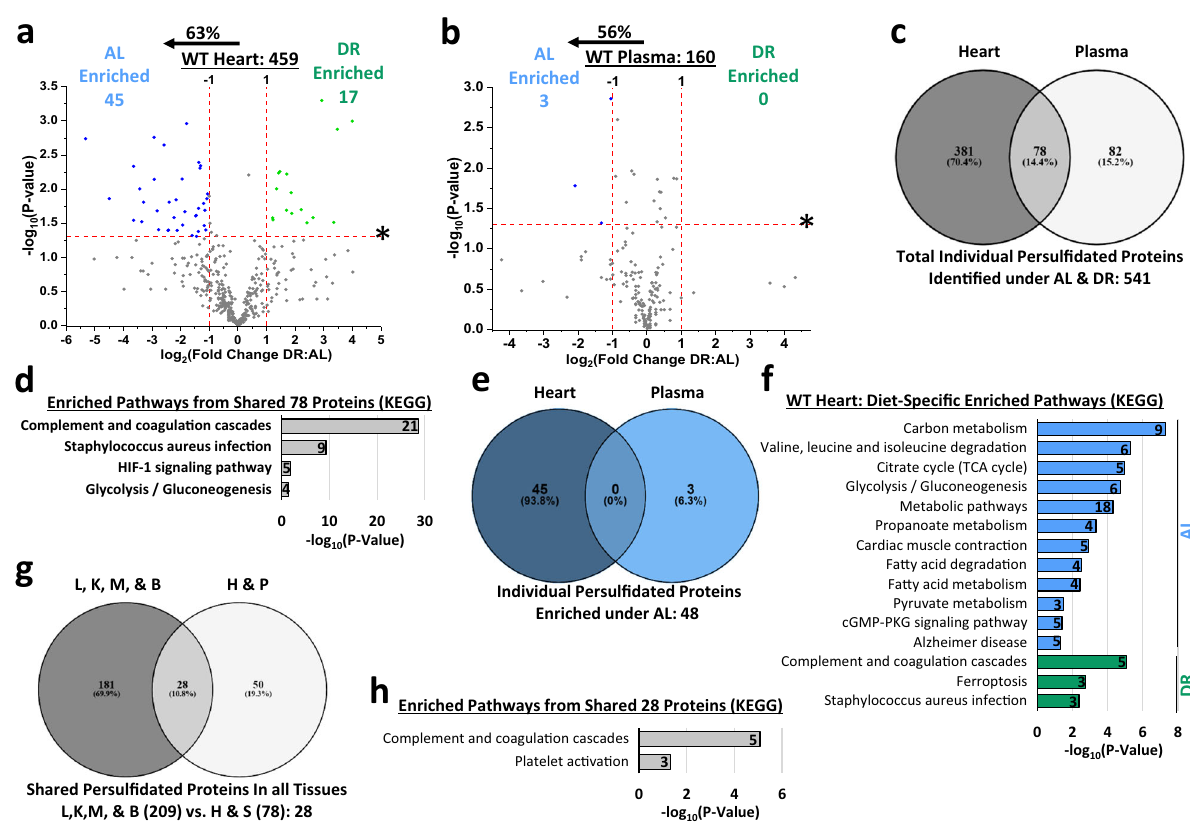
Fig. 4 Persul fi domes of heart and plasma respond differently to diet compared to those of liver, kidney, muscle, and brain. a , b Volcano plots showing differentially abundant persul fi dated proteins in heart ( a ) and plasma ( b ) from AL ( n = 4 mice/group) versus DR ( n = 5 mice/group) cystathionine γ -lyase (CGL) wildtype (WT) mice. The log 2 (Fold Change DR:AL) X-axis displays the average fold change in spectral counts for each identi fi ed persul fi dated protein while the − log 10 Y-axis displays the calculated P value when comparing the individual spectral count values for each identi fi ed persul fi dated protein in a speci fi c tissue from AL versus DR fed mice with P values obtained from two-sided Student ’ s t test. The number of total persul fi dated proteins identi fi ed in each tissue are given next to the tissue name, while blue (AL enriched) and green (DR enriched) colored dots and text indicate persul fi dated proteins reaching both biological- and statistical-thresholds. Gray color dots indicate persul fi dated proteins not reaching the criteria for both biological and statistical signi fi cance for enrichment under either diet. The percentage and direction of proteins skewed toward AL is provided above the tissue label. c Venn diagram of shared and non-shared persul fi dated proteins in heart and plasma. d KEGG biological pathway enrichment of the shared 78 proteins found in heart and plasma via g:Pro fi ler analysis. e Overlap of AL enriched persul fi dated proteins in heart and plasma. f KEGG biological function and pathway enrichment of AL enriched (blue bars) or DR enriched (green bars) persul fi dated proteins in heart. g Venn diagram of shared and unshared persul fi dated proteins amongst all 6 tissues. h KEGG biological function and pathway enrichment of the shared 28 proteins found in all six tissues via g: Pro fi ler analysis. The numbers in the bars indicate individual persul fi dated proteins identi fi ed for that speci fi c pathway. Statistical signi fi cance for pathway enrichment plotted as the adjusted − log 10 ( P value) and was auto-calculated via the g:Pro fi ler g:SCS algorithm for KEGG database that utilizes multiple testing corrections. See also Supplementary Fig.